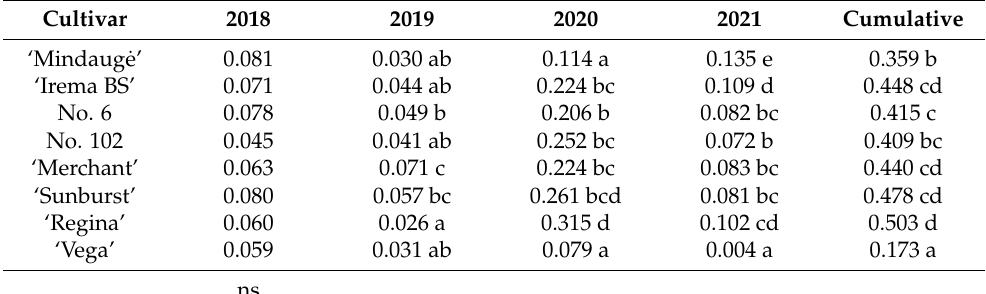
Table 4. Sweet cherry yield efficiency (kg/cm 2 TCSA). Values marked with different letters are statistically different within the columns ( p ≤ 0.05); ns—non-significant.